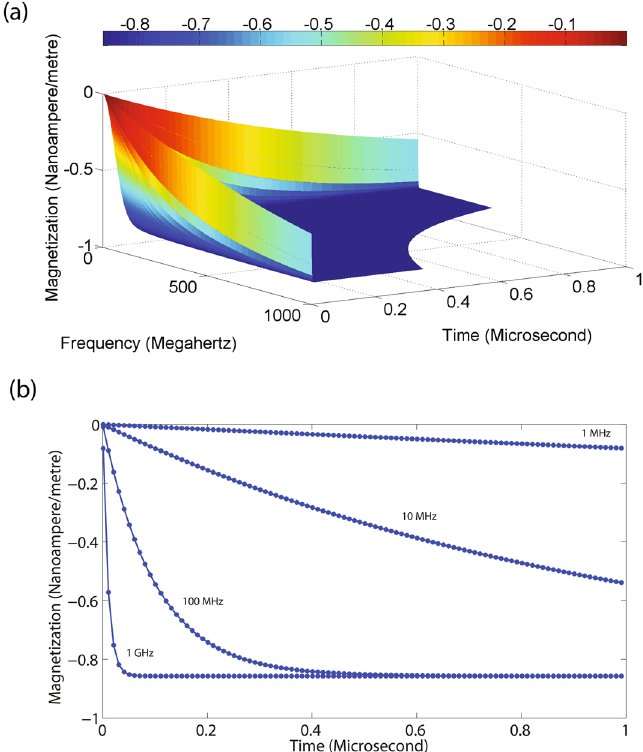
Figure 4. Magnetization noise in NMR ( a ) The noise level (in units of nA/m) shows an exponential decrease with an increase in frequency and time eventually reaching a stationary value. The frequency was varied from 1 MHz to 1 GHz and time was varied from 0 s to 1 µ s . ( b ) The time dependence of noise at some select precession frequencies viz. 1MHz , 10MHz , 100 MHz and 1 GHz also shows an exponential decrease with time. The total value of noise increases as the precession frequency